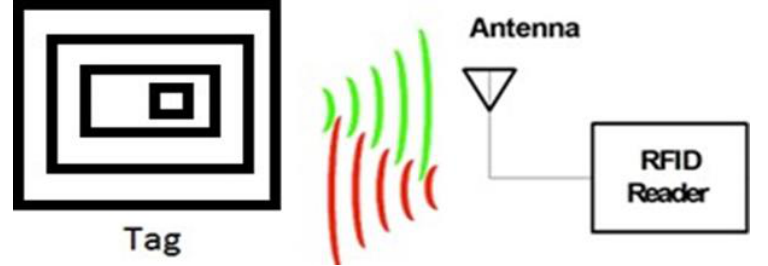
Figure 1. RFID system: Reader and Tag communication system.